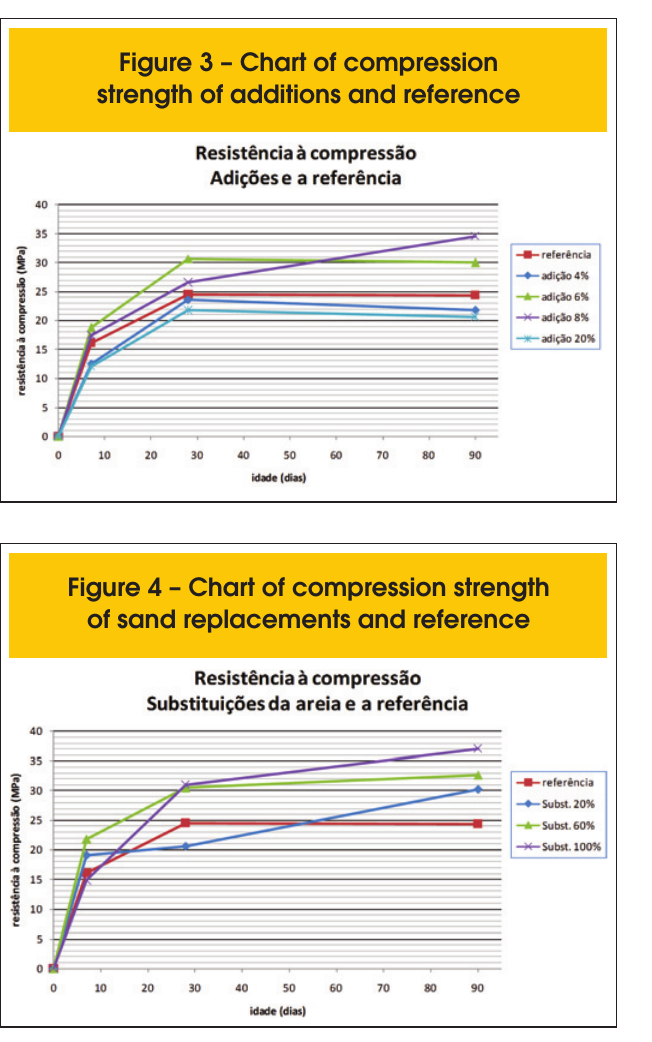
Table 2 – Compression strenght, w/c ratio and consistency index of sand replacements and reference